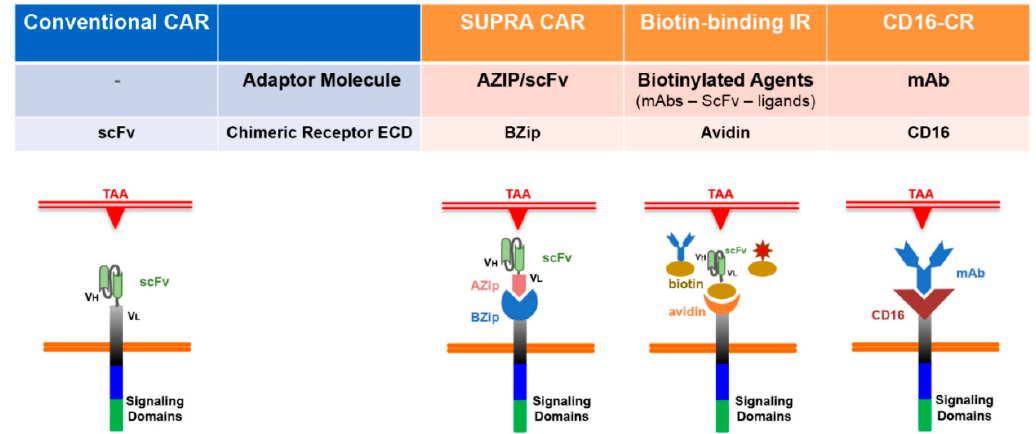
Figure 2. Structural design of Universal Chimeric Receptors: comparison versus canonical CARs. (a) SUPRA CAR system is a universal receptor consisting of two-components: a leucine zipper adaptor (zipCAR) on T cells and a separate scFv with leucine zipper adaptor (zipFv) molecule targeting specific antigens. (b) The biotin-banding immune receptor contains dimeric avidin (dcAv BBIR) able to bind a variety of biotinylated antigen-specific molecules (scFV, mAbs or tumor-specific ligands) expressed on the surface of target cells. The BBIR “lock-key” mechanism is based on binding of biotin to avidin. (c) The CD16 binding module of the CD16-CR is combined the transmembrane and signaling domains of the CR. Virtually any mAb can redirect Fc γ R-CR T cells toward TAAs expressed by malignant cells.